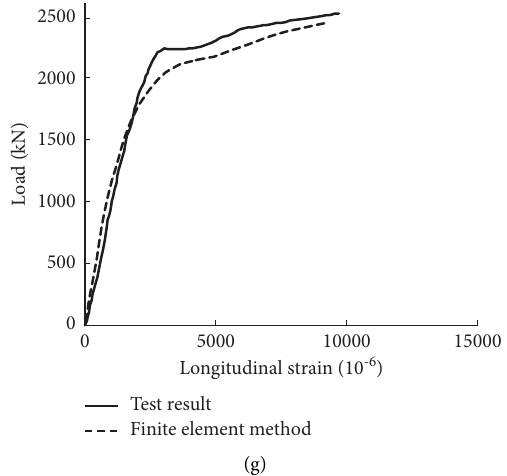
Figure 6: Comparison between calculated and experimental results: (a) GRCH1, (b) GRCH2, (c) GRCH3, (d) GRC4, (e) GRCH5, (f) GRCH6, and (g)